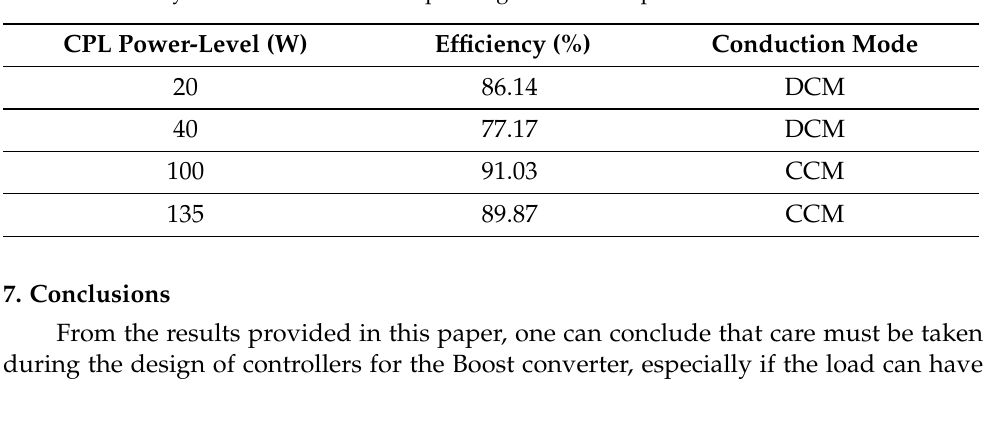
Figure 14. Output voltage ( v ), output current ( io ), and inductor current ( i ) for the Boost converter operating in closed-loop, with a CPL power demand of ( a ) 20, ( b ) 40, ( c ) 100, and ( d ) 135 W. 50 V/div is used for v , 1 A/div for io , and 5 A/div for i (the probe is configured for x/10). The output voltage and both currents are stabilized in the four scenarios despite the conduction mode type. Table 3. Efficiency of the Boost converter operating in